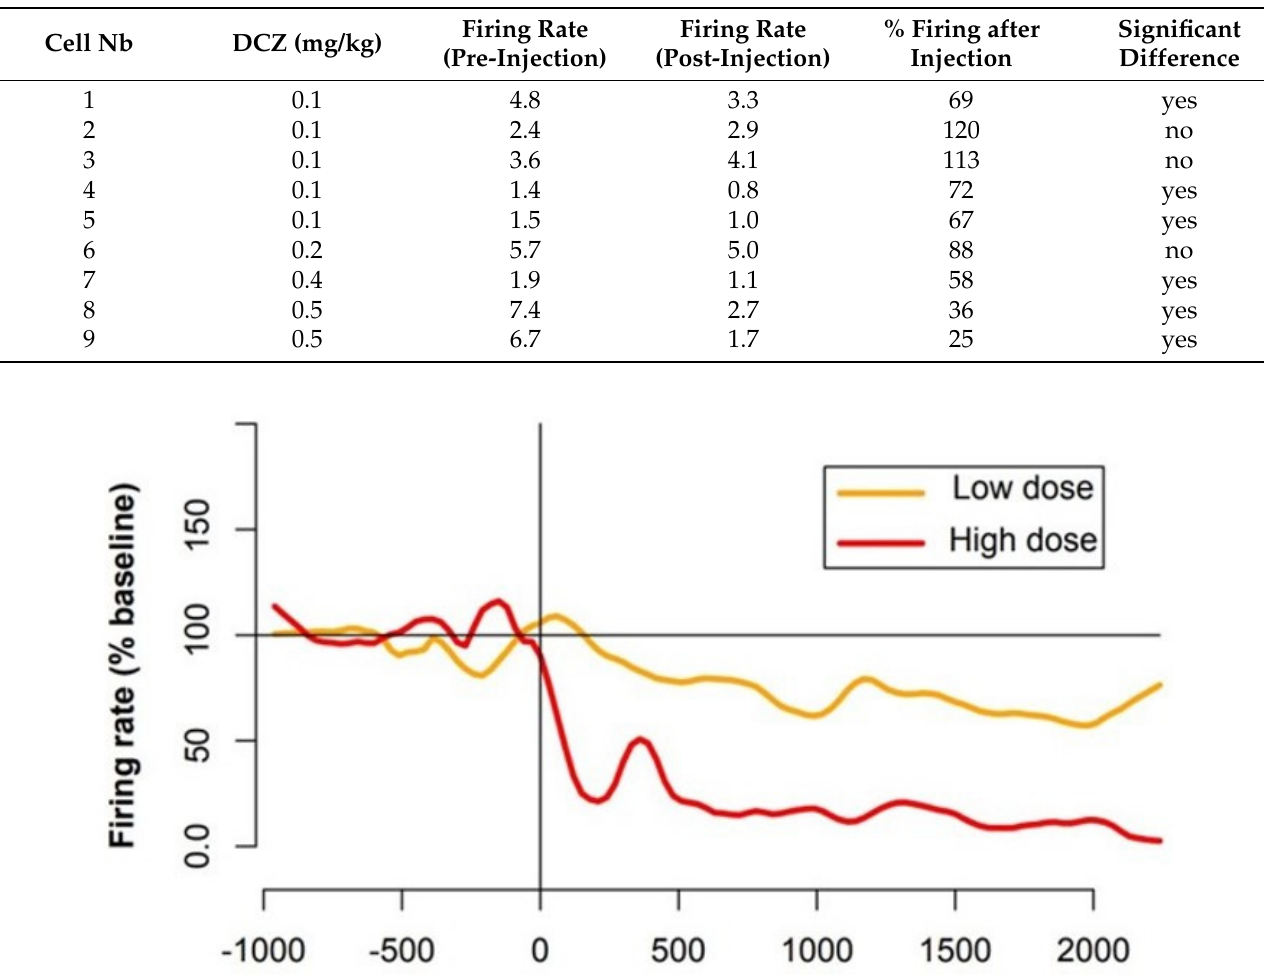
Table 1. Influence of DCZ injection on individual LC units.